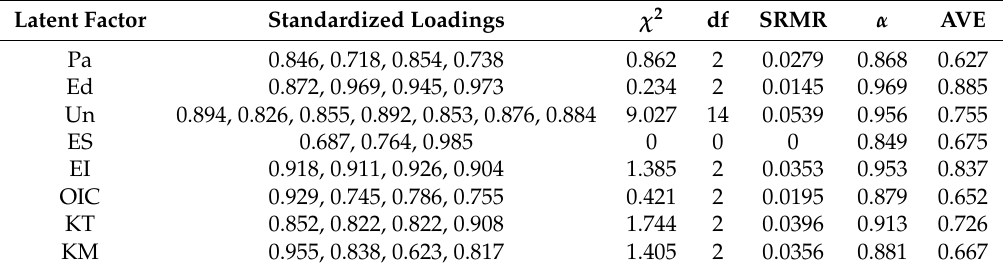
Table 2. Confirmatory factor analysis of the tested model. SRMR, standard root mean squared residual. Latent Factor Standardized Loadings χ 2 df SRMR